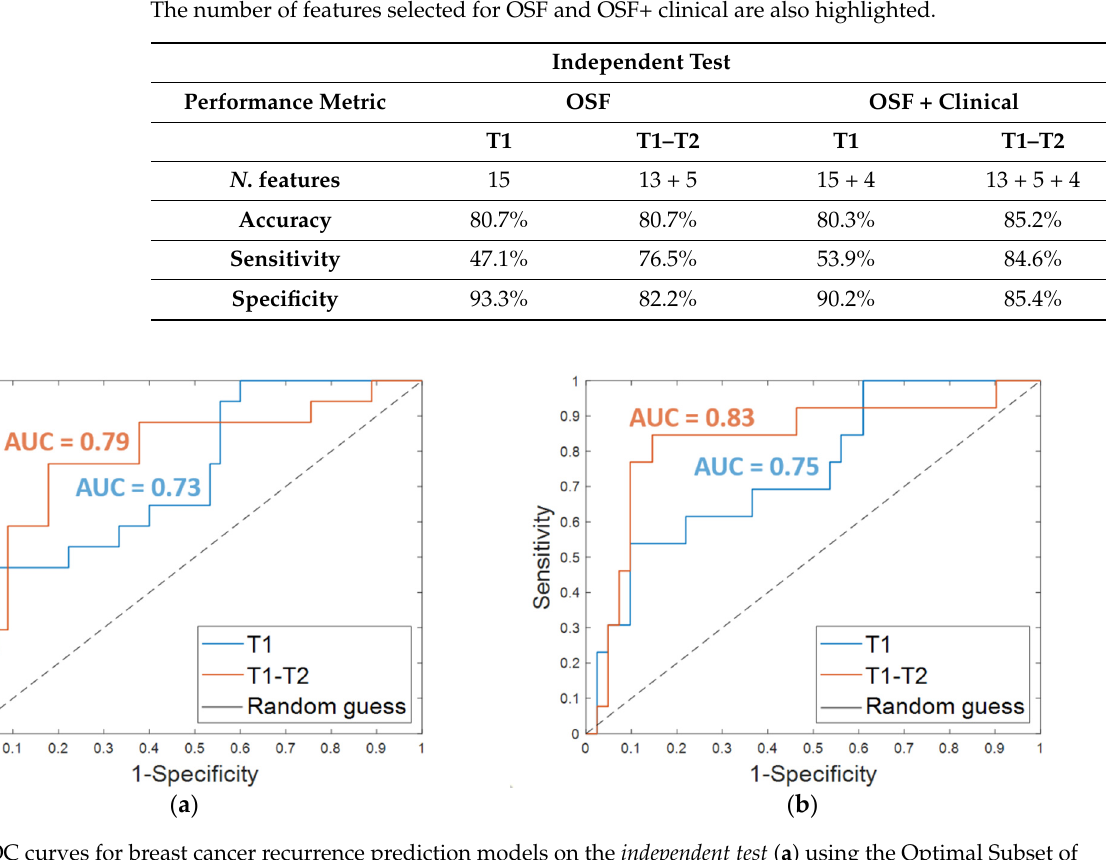
Figure 4. ROC curves for breast cancer recurrence prediction models on the independent test ( a ) using the Optimal Subset of Features alone and ( b ) combined with the clinical features, respectively. The AUC values are also highlighted.